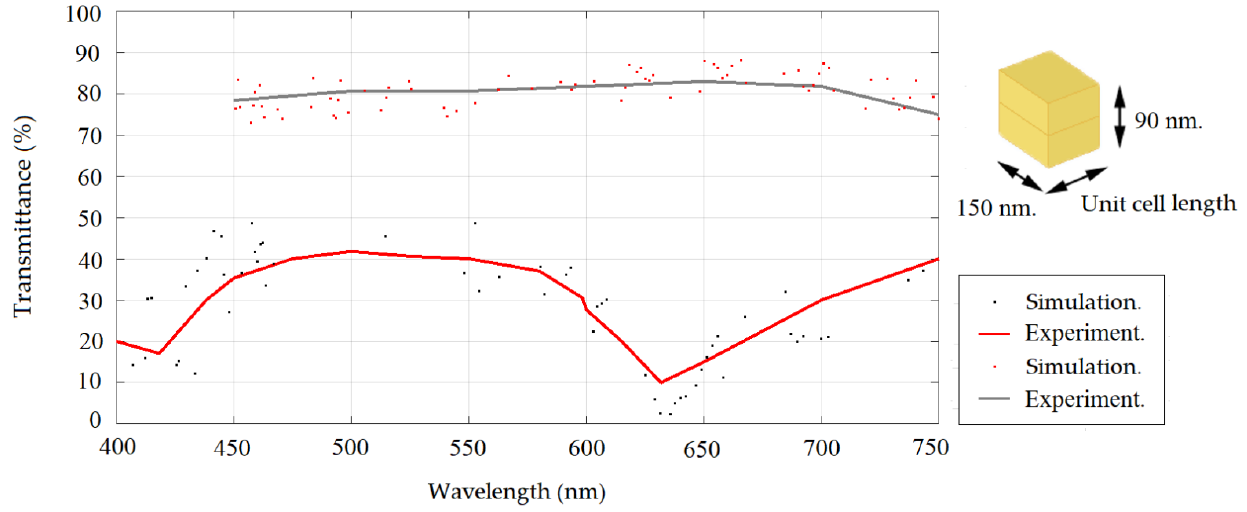
Figure 9. Comparison of our simulation and experimental results [25,28] using Al fiber (W = 150 nm, H = 90 nm and W = 70 nm, H = 200 nm, respectively).